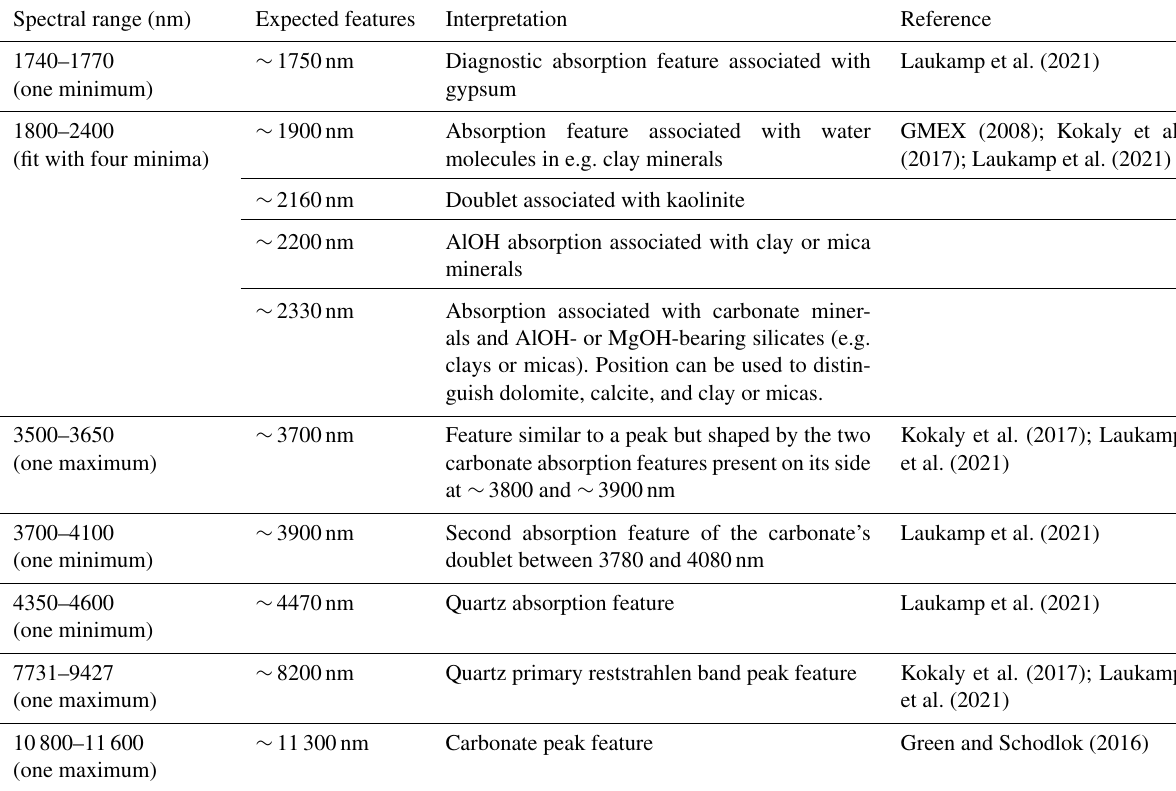
Table 3. Spectral ranges used to extract the positions and depths of specific absorption and emission features using minimum wavelength mapping